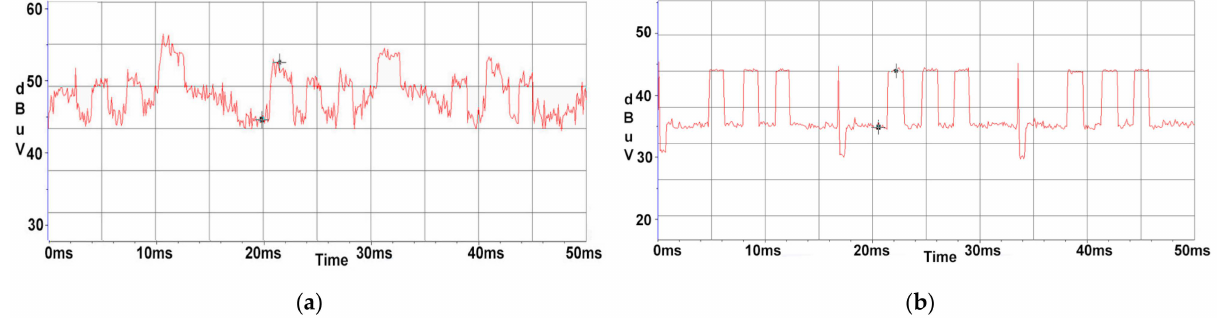
Figure 7. AOC display: ( a ) displayed waveform using a Max Peak detector; ( b ) displayed waveform using an Average detector.